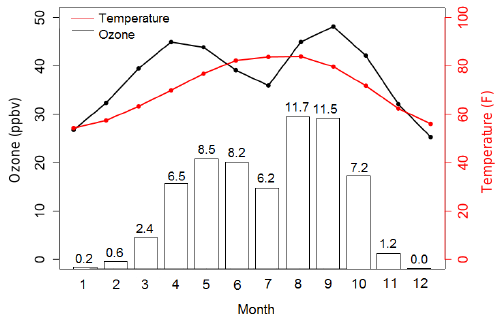
Figure 5. The 1990–2015 mean monthly MDA8 ozone over the HGB area (black line), overlaid with the average number of ex- ceedance days by month (bars) and the HGB-mean temperature (red line). An exceedance day is defined when MDA8 ozone at one or more monitors in HGB is higher than